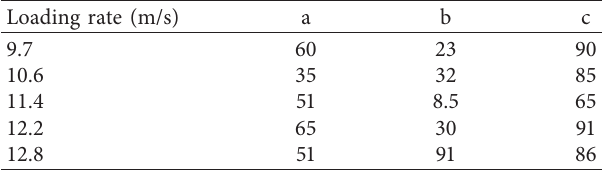
Table 8: Crack initiation angle θ ( °